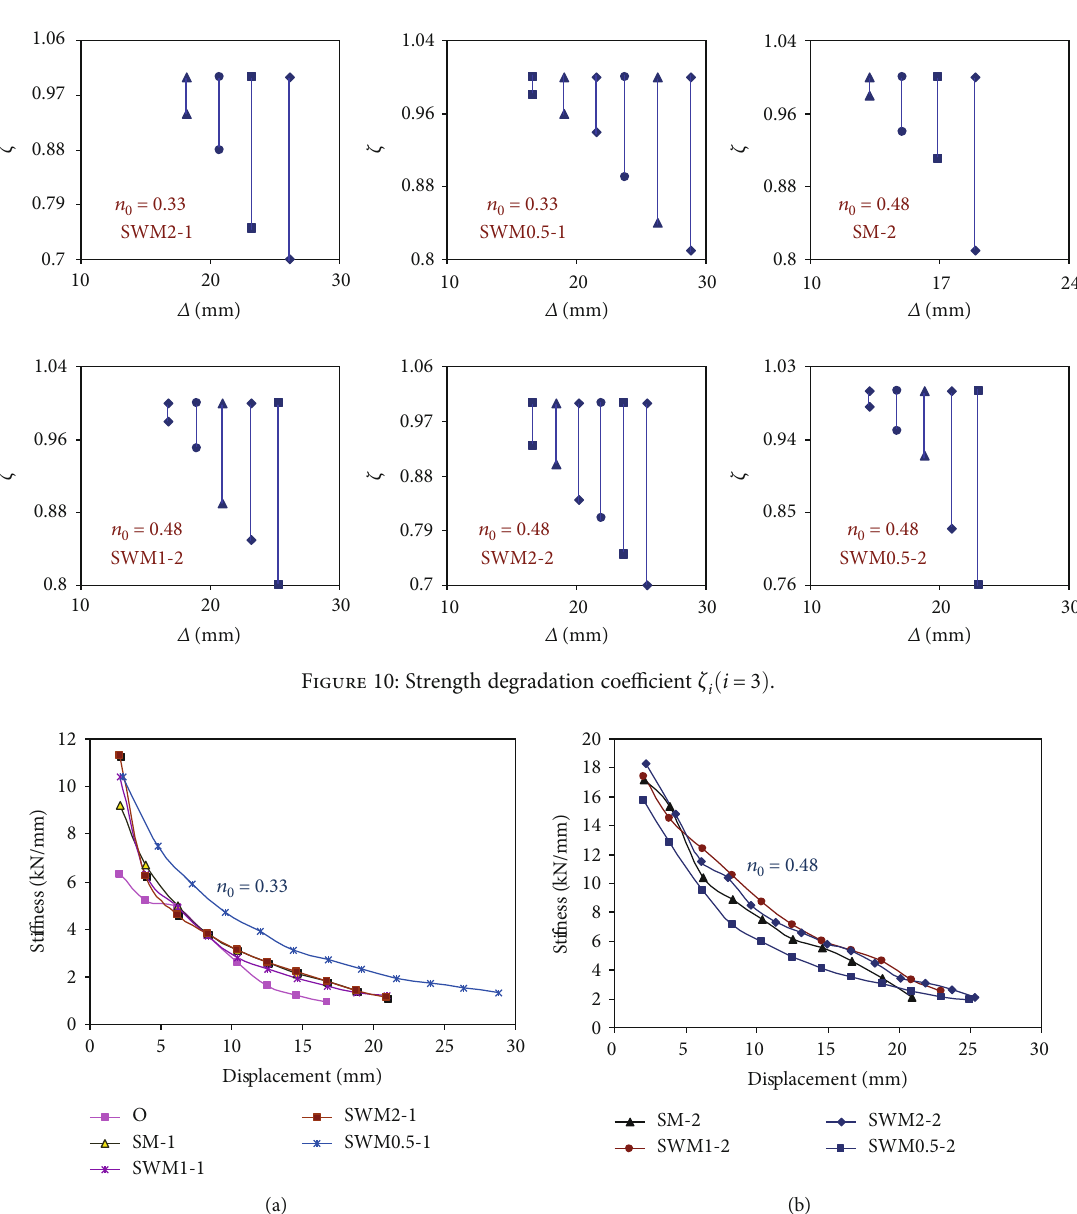
Figure 11: Sti ff ness degradation of